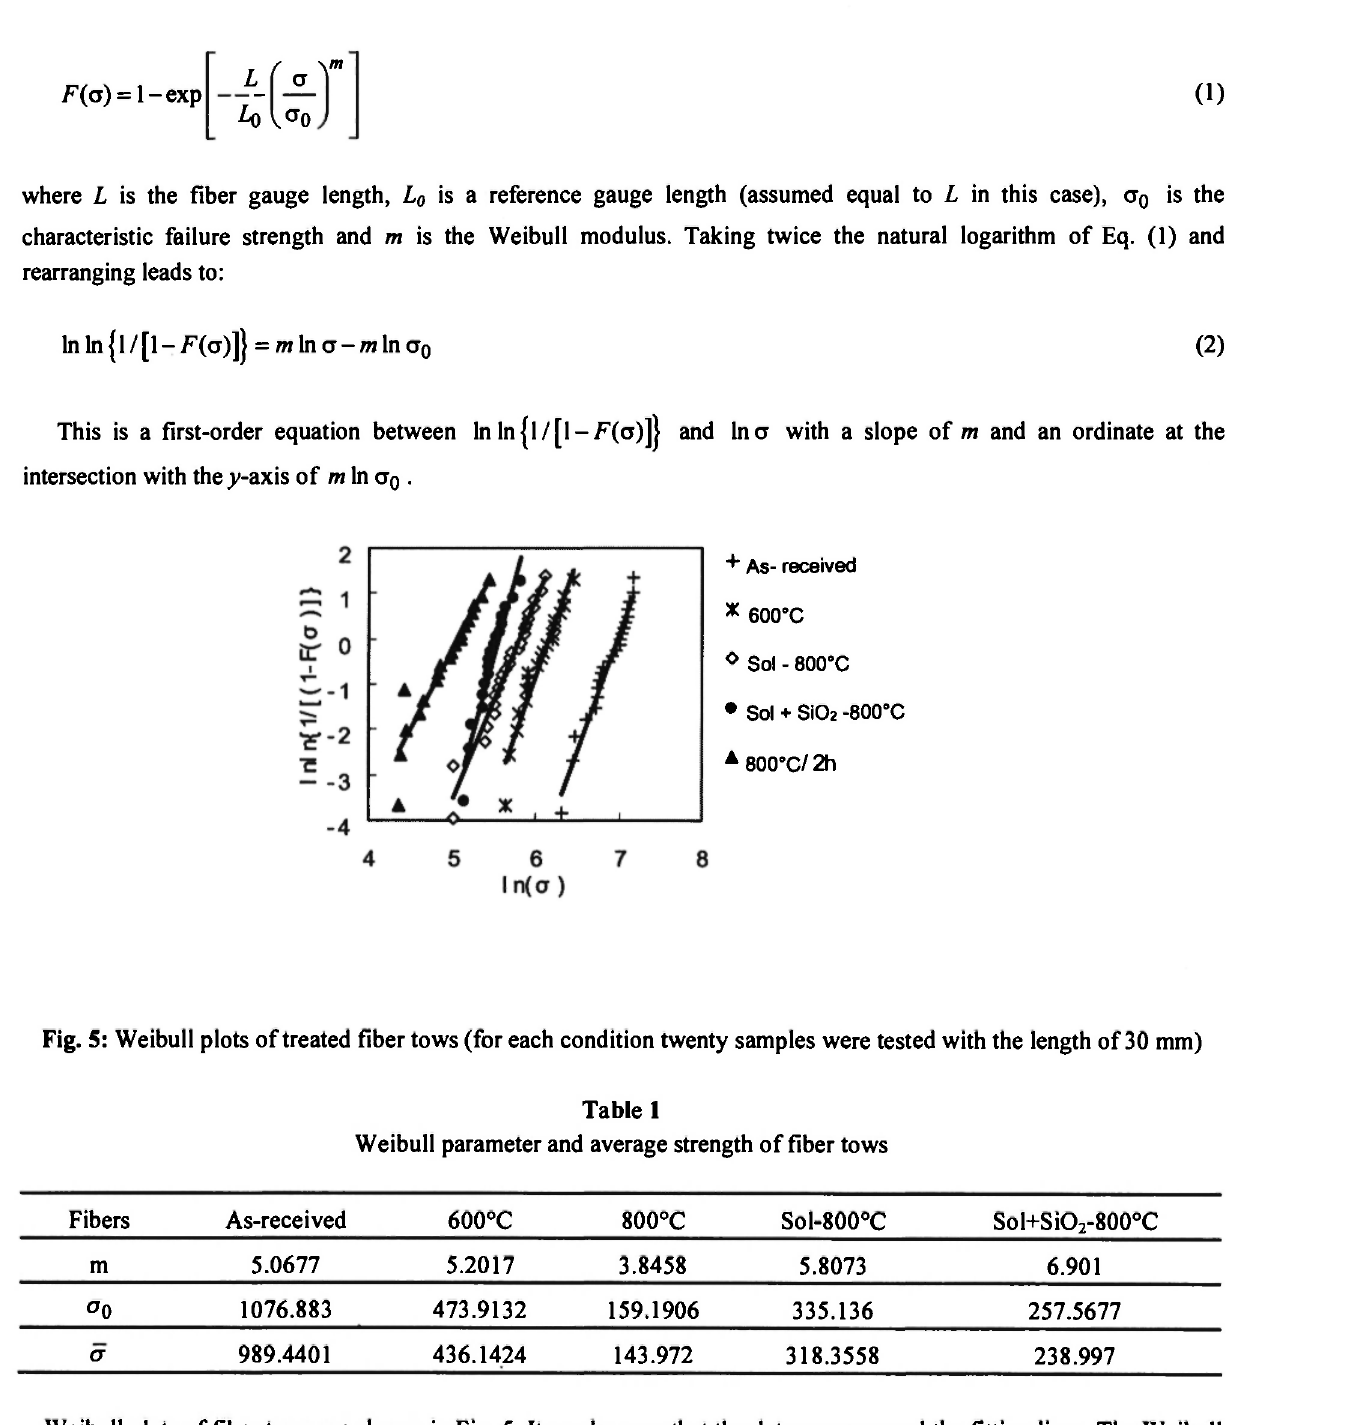
Weibull parameter and average strength of fiber